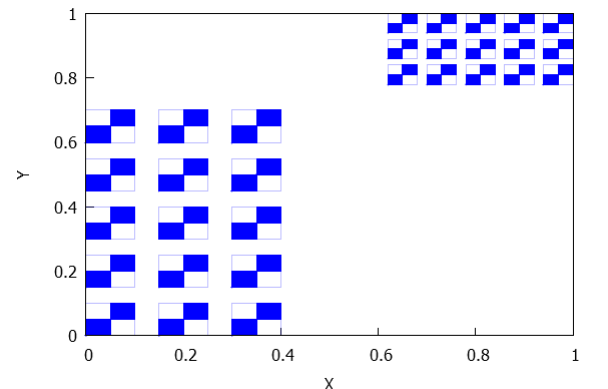
Figure 14. A and B no mixing. Observe that f ( A ) ∩ B = ∅ and under the theoretical assumptions we